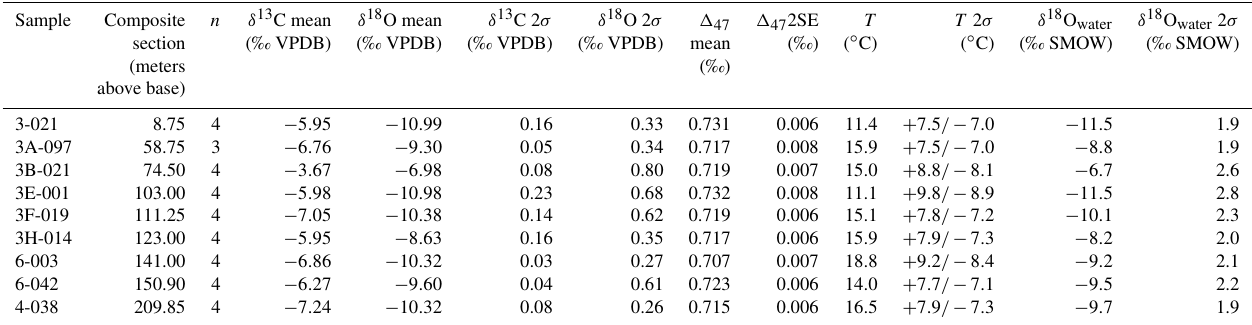
Figure 4. Carbonate δ 13 C and δ 18 O for White Pagoda samples. Black symbols represent drill spot measurements of inferred primary calcite and red symbols represent drill spot measurements of inferred secondary calcite (measured at KU). Gray with green symbols represent mean δ 13 C and δ 18 O measured on larger inferred primary calcite samples at CUB. Table 2. Primary carbonate stable isotope data measured at CUB ( (cid:49) 47 , δ 13 C and δ 18 O) for the White Pagoda Site. Clumped isotopes and interpreted temperatures follow Petersen et al. (2019). Meteoric water δ 18 O calculated from δ 18 O carb (CUB measured), and clumped temperatures following Friedman and O’Neil